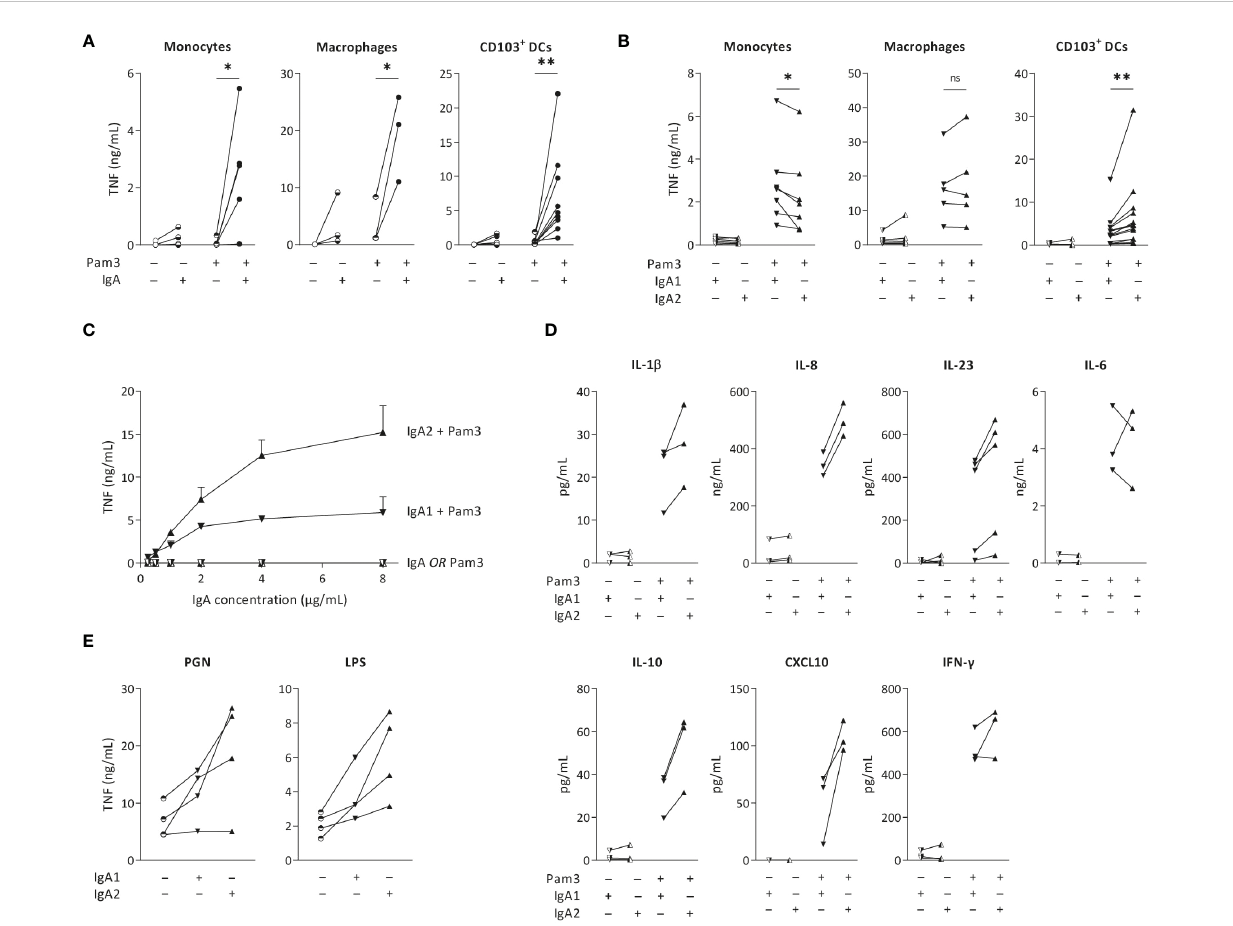
FIGURE 1 IgA2 immune complexes selectively increase cytokine production by intestinal CD103 + DCs. Monocytes, macrophages and CD103 + dendritic